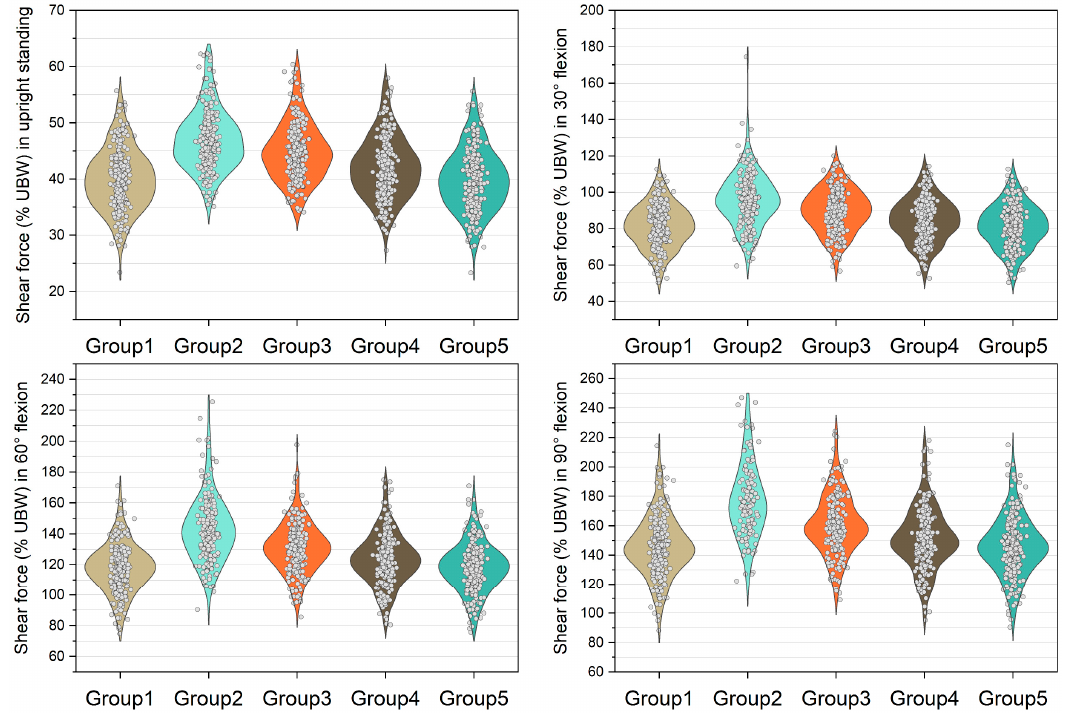
Figure 5. Normalized shear force expressed by % upper body weight (%UBW) on the L5/S1 level. The grey circle denotes the value computed by each sample in each group.